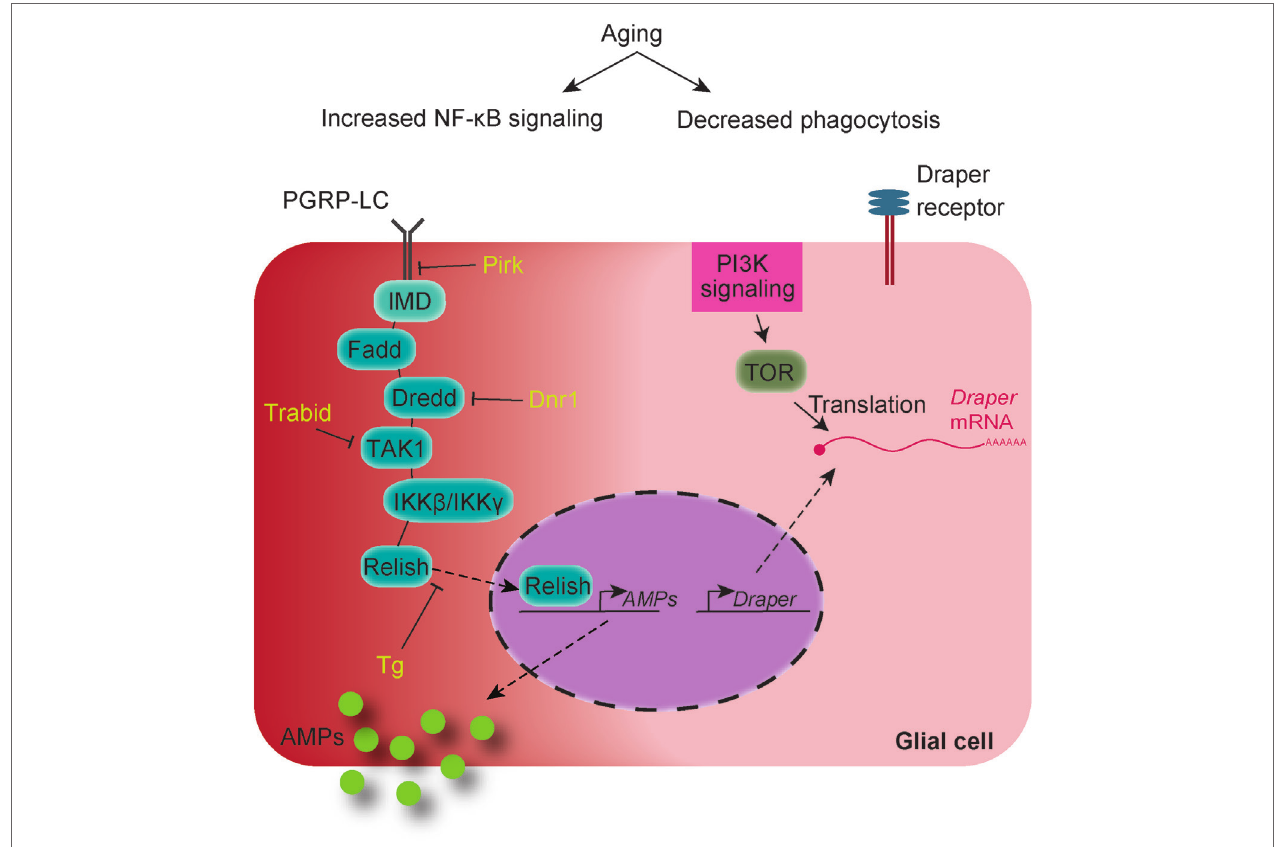
FiGURe 1 | Age-dependent changes in innate immune pathways in Drosophila glial cells: immune deficiency (IMD) pathway (on the left) shows age-dependent activation resulting in increased levels of antimicrobial peptides (AMPs) in middle and old-aged adults in absence of microbial challenge. Mutations in genes encoding specific IMD negative regulators namely Dnr1 , trabid , Transglutaminase (Tg,) and pirk release the pathway allowing activation of Relish and subsequent transcription of downstream genes including those encoding AMPs. Aging also affects expression of the phagocytic receptor Draper (on the right) leading to inefficient phagocytic capacity of glial cells. Draper expression levels in the healthy brain are regulated via phosphoinositide-3-kinase signaling activity that mediates TOR-dependent translation of draper mRNA in glial cells. Age related decline in the activity of this signaling cascade leads to reduction in protein levels of Draper in